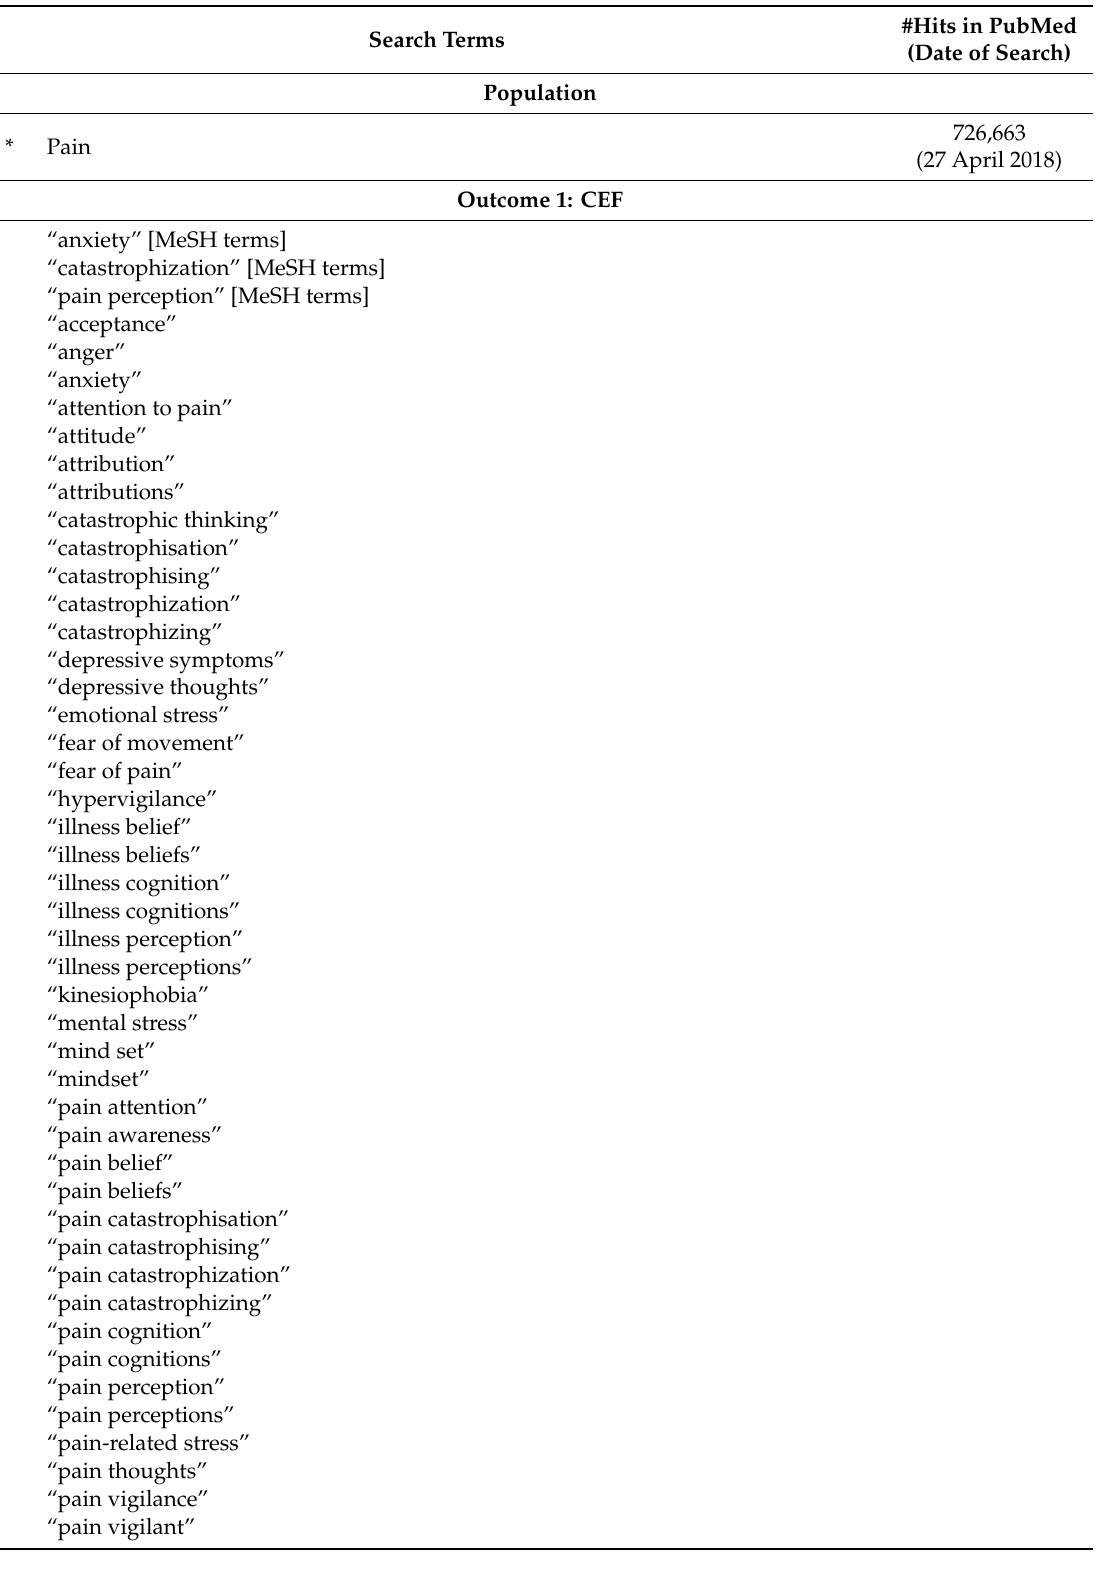
Table A1. Complete systematic search strategy for